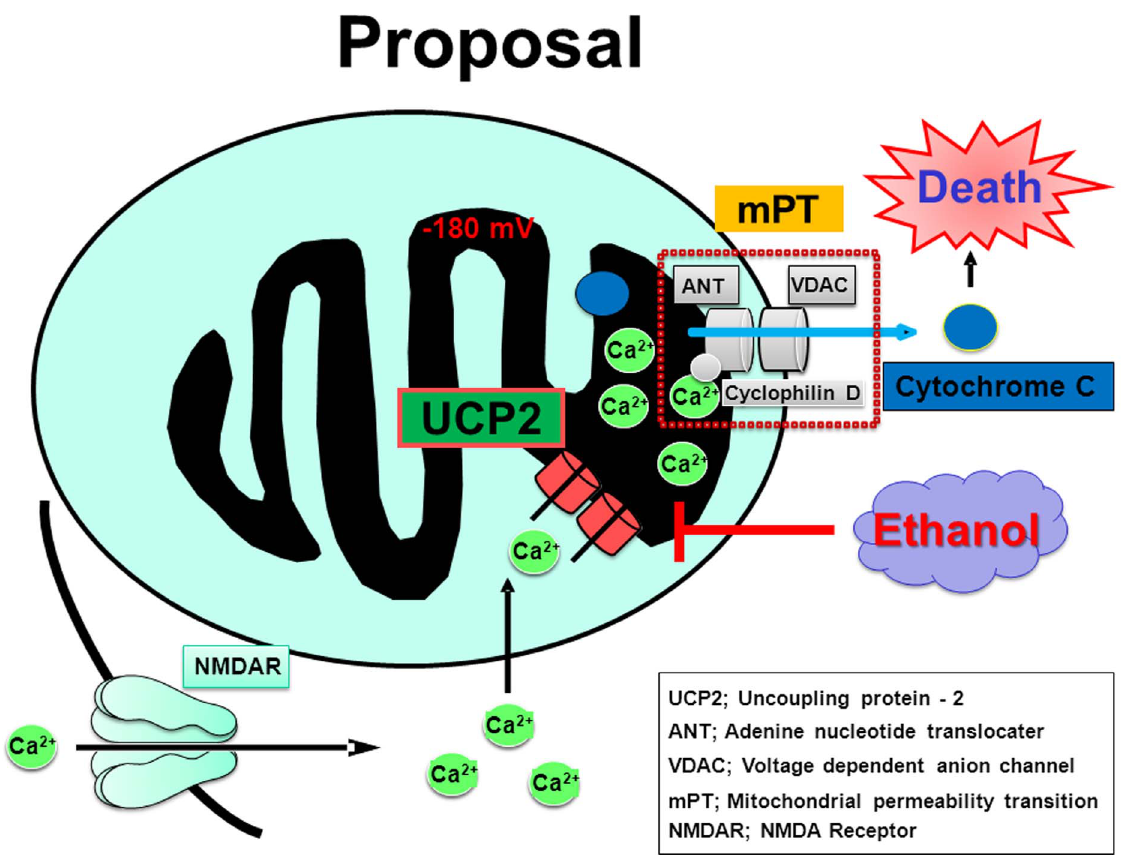
Figure 12. Proposed model of inhibition by ethanol of mitochondrial Ca 2 + influx. Activation of NMDAR would lead to the incorporation of cytosolic Ca 2 + into mitochondrial matrix in a manner relevant to UCP2 expressed at inner membranes toward the orchestration of mPTP responsible for the leakage of a variety of cytotoxic molecules in neurons. Ethanol could inhibit the mitochondrial Ca 2 + influx occurred after the interaction between UCP2 and NMDAR channels through an unidentified mechanism.